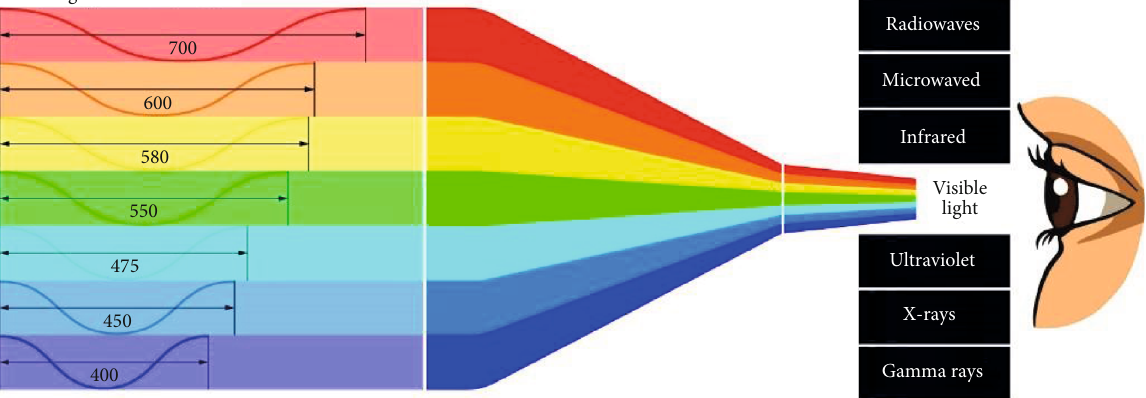
Figure 2: The main colors (RBG) for human vision